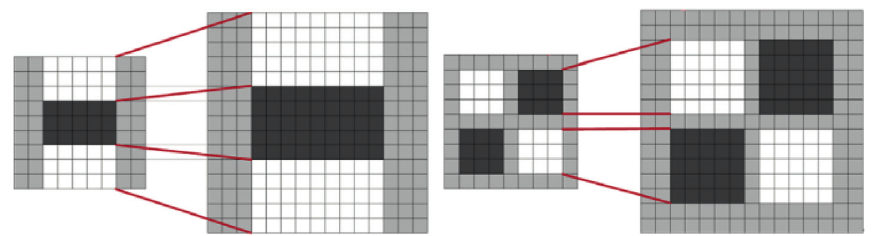
Figure 6: The filter structure increased in size by a minimum of